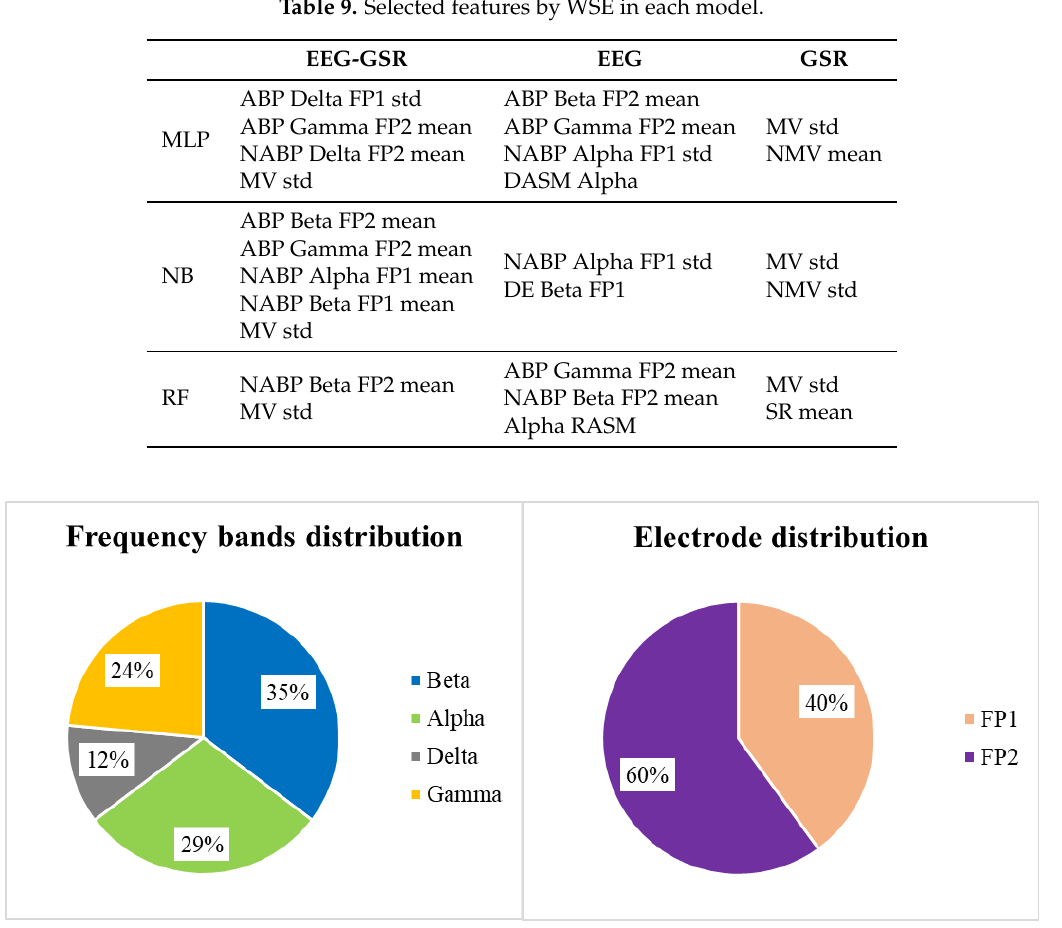
Figure 6. Distributions of EEG features by frequency bands and electrodes.